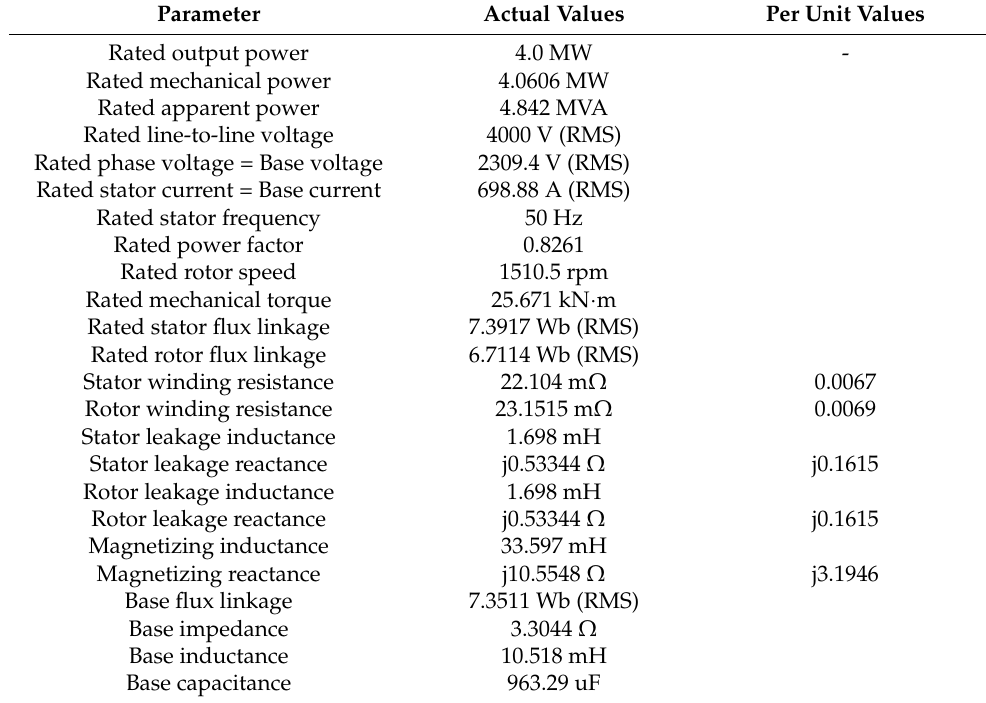
Table 3. Squirrel-cage induction generator parameters.